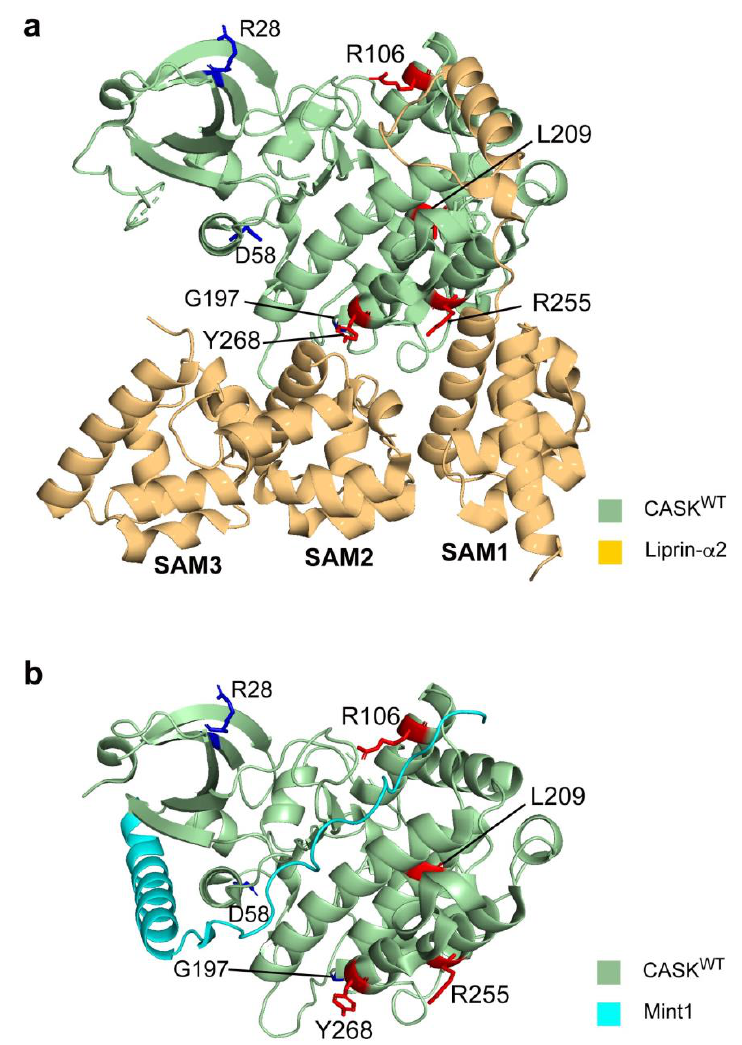
Figure 6. The missense mutations responsible for the survival of CGC are located in the binding interface between the CaMK domain of CASK and Liprin-α2 or Mint1. ( a ) Co-crystallography of the